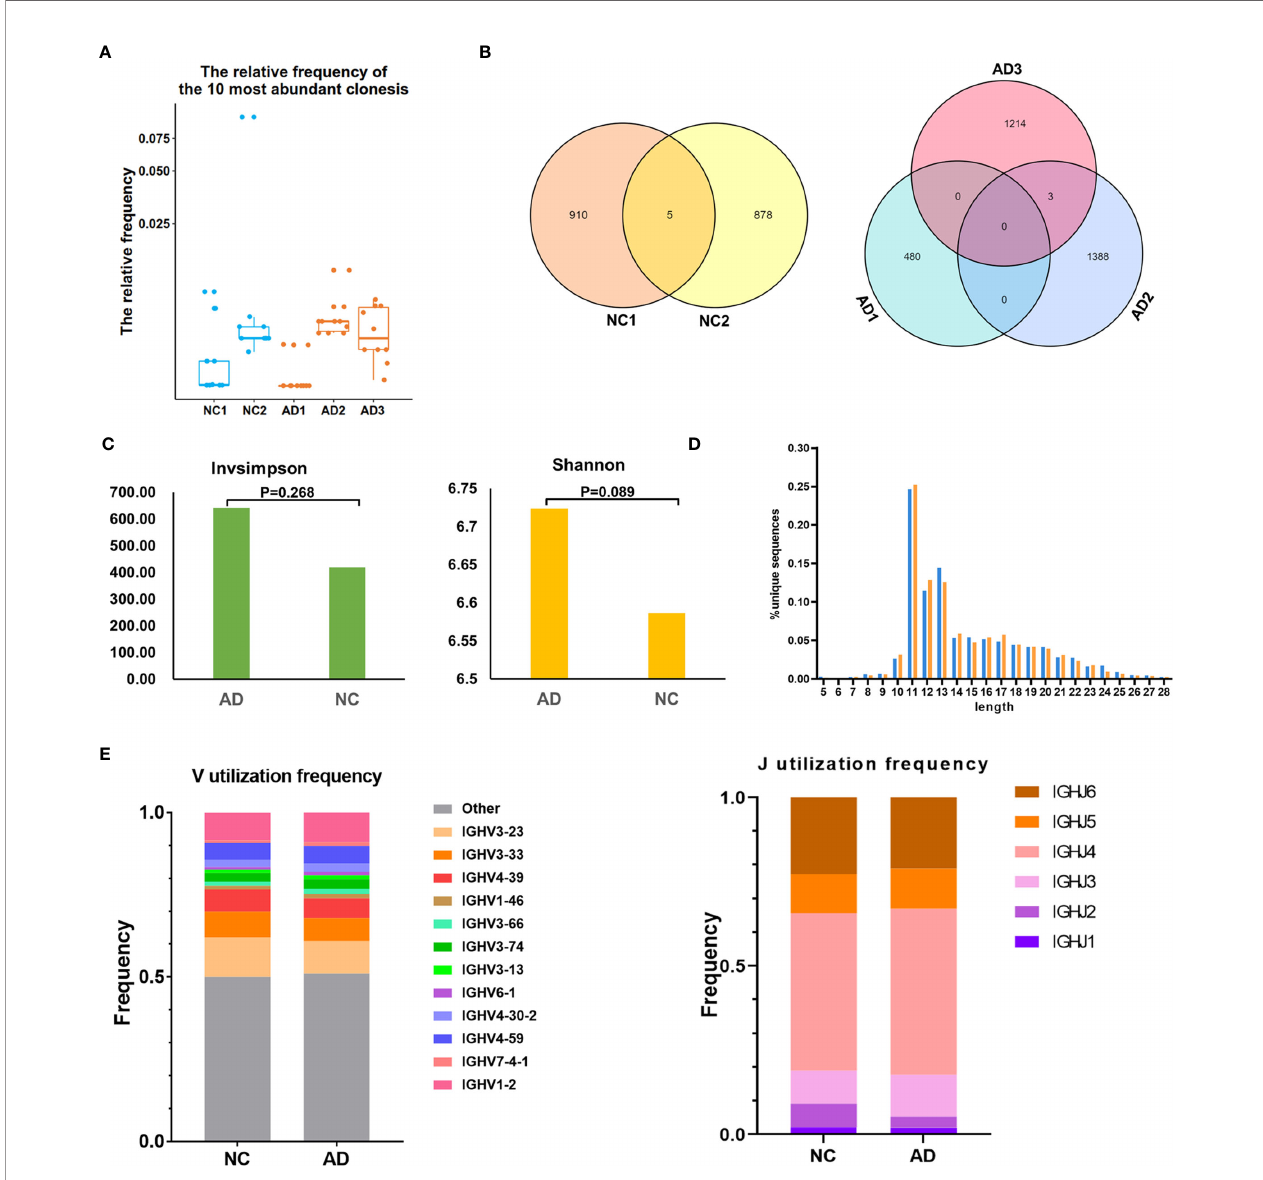
FIGURE 5 | B cell receptor (BCR) repertoire analysis. (A) Box plot showing the top 10 high-frequency B cell clonotypes for each sample in the present study. (B) Venn diagrams of the public B cell clonotypes within the Alzheimer ’ s disease (AD) and normal controls (NC). (C) Averages of the InvSimpson index and Shannon – Weiner index of each sample are used to compare the BCR diversity of the AD group and NC. (D) Distribution of the CDR3 amino acid length of the BCR in the AD group and NC. (E) V and J genes usage frequency stacked histogram showing the distribution of common V and J genes of the BCR in the AD group and NC